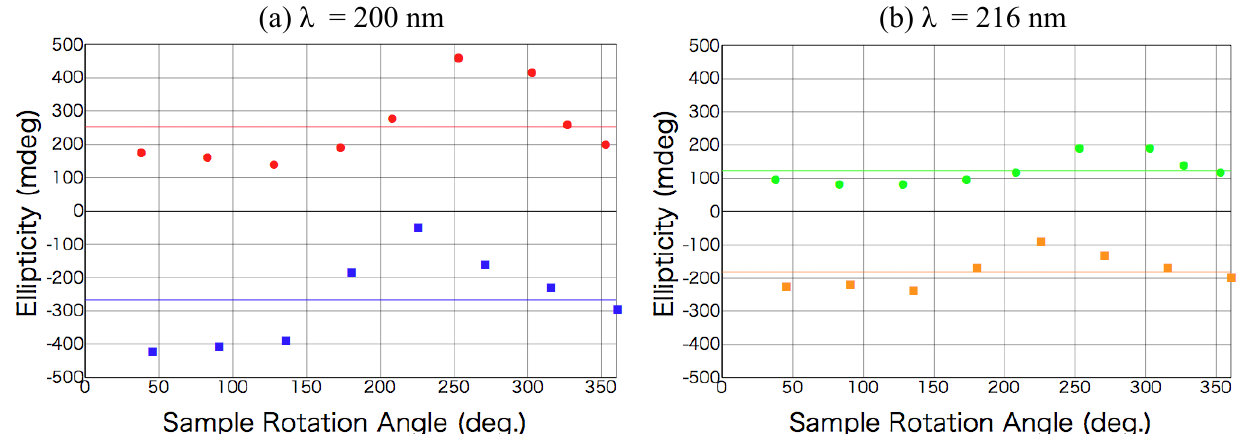
Figure 8. Sample rotation angle θ dependence of CD peak intensity ((a) CD wavelength 200 nm and (b) 216 nm) for DL -phenylalanine film after left-handed CPL (red for 200 nm in (a) and green for 216 nm in (b)) and right-handed CPL (blue for 200 nm in (a) and brown for 216 nm in (b)) irradiation. Straight lines show θ -independent non-zero CD components for each